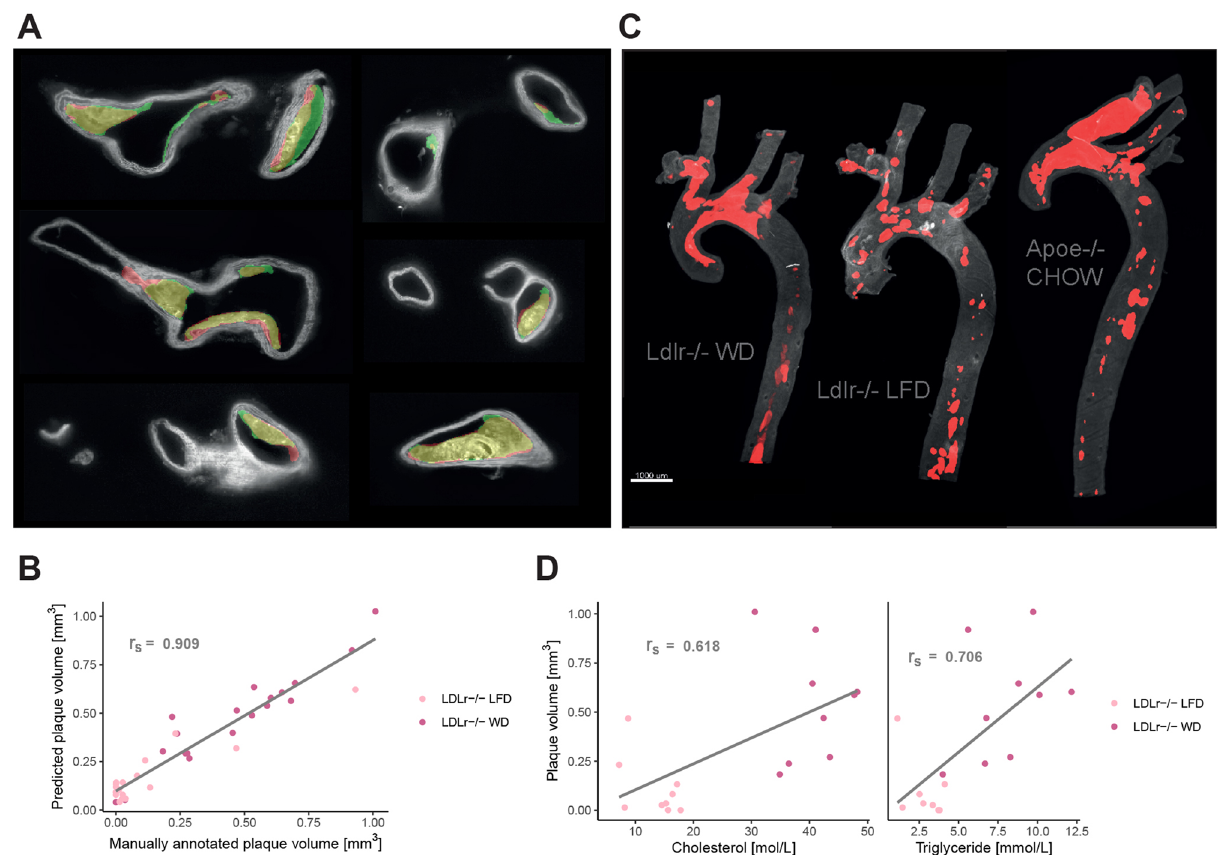
Figure 1. Plaque identification based on tissue autofluorescence. ( A ) Images of the aorta with annotated plaques shown in green and plaque predicted by the deep learning model in red (overlap in yellow). All images are part of the test set and derived from two aortas of Apoe−/− mice on western diet. ( B ) Spearman correlation (r s = 0.909, p value < 2.2e−16) between manually annotated plaque volume and plaque volume predicted by the deep learning model. Regression lines added for visualization purposes. ( C ) Plaque predictions by the model in 3D reconstructed aortas. ( D ) Spearman correlation of plaque volume with plasma cholesterol (r s = 0.618, p value = 0.007) and triglyceride (r s = 0.706, p value = 0.002). Regression lines are added for visualization